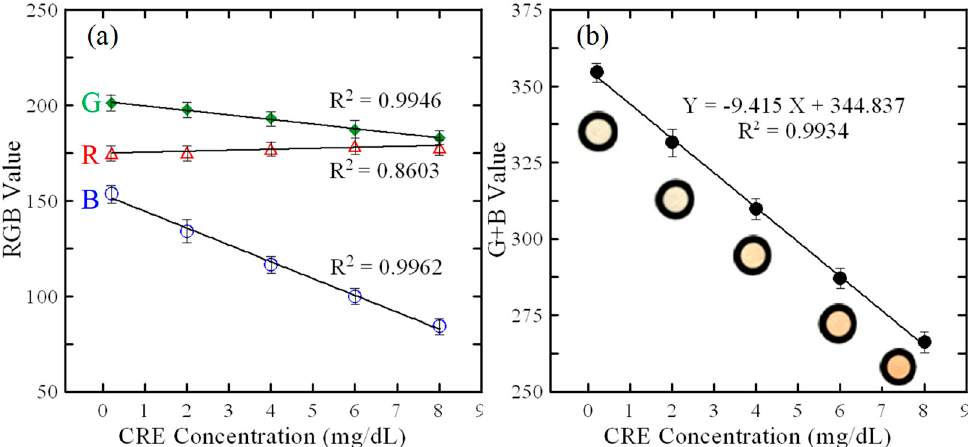
Figure 4. ( a ) RGB intensity values of creatinine samples and ( b ) variation of G (green) + B (blue) intensity (and associated color images) with creatinine concentration in the range of 0.2~8 mg/dL. (Note that the reaction temperature and reaction time are 37 °C and 5 min, respectively.).